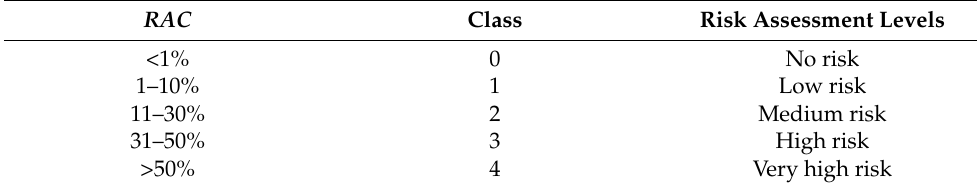
Table 3. Category of RAC